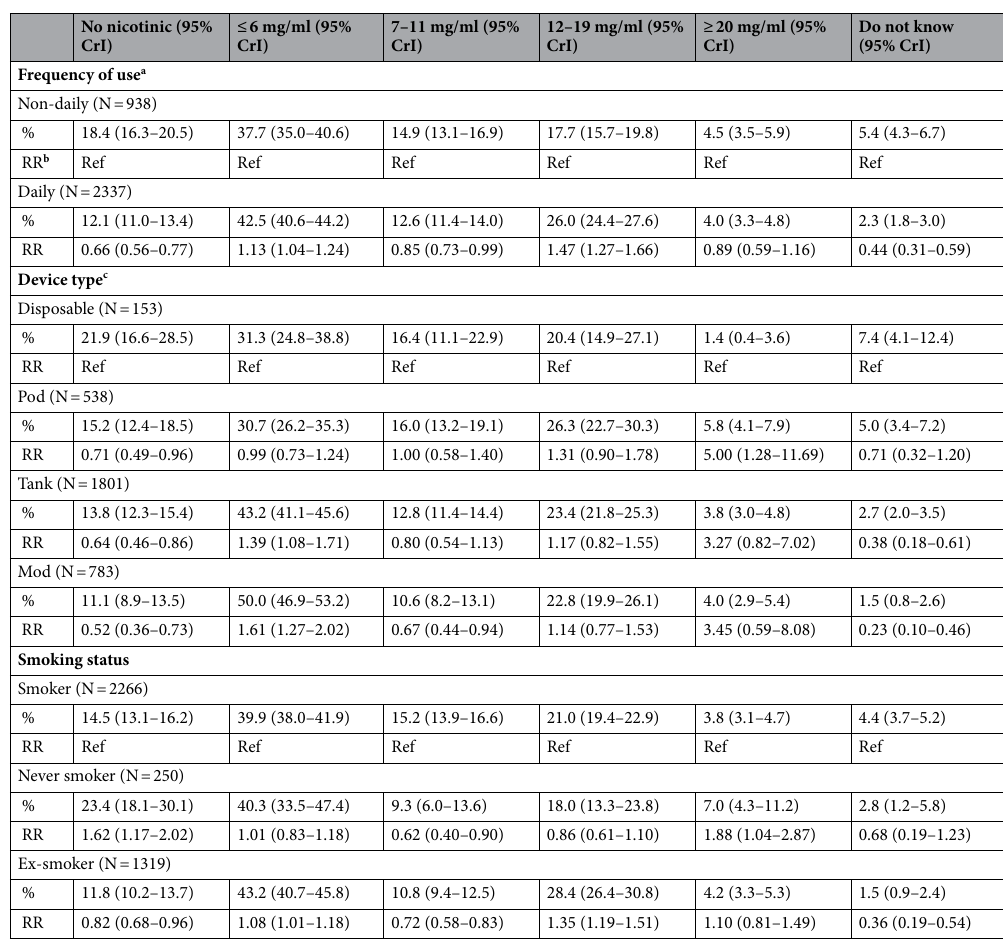
Table 3. Nicotine concentration used by frequency of use, device type and smoking status among e-cigarette users. a Percentages are unweighted. b RR represents risk ratio. c Participants who used combinations of products or NRT were